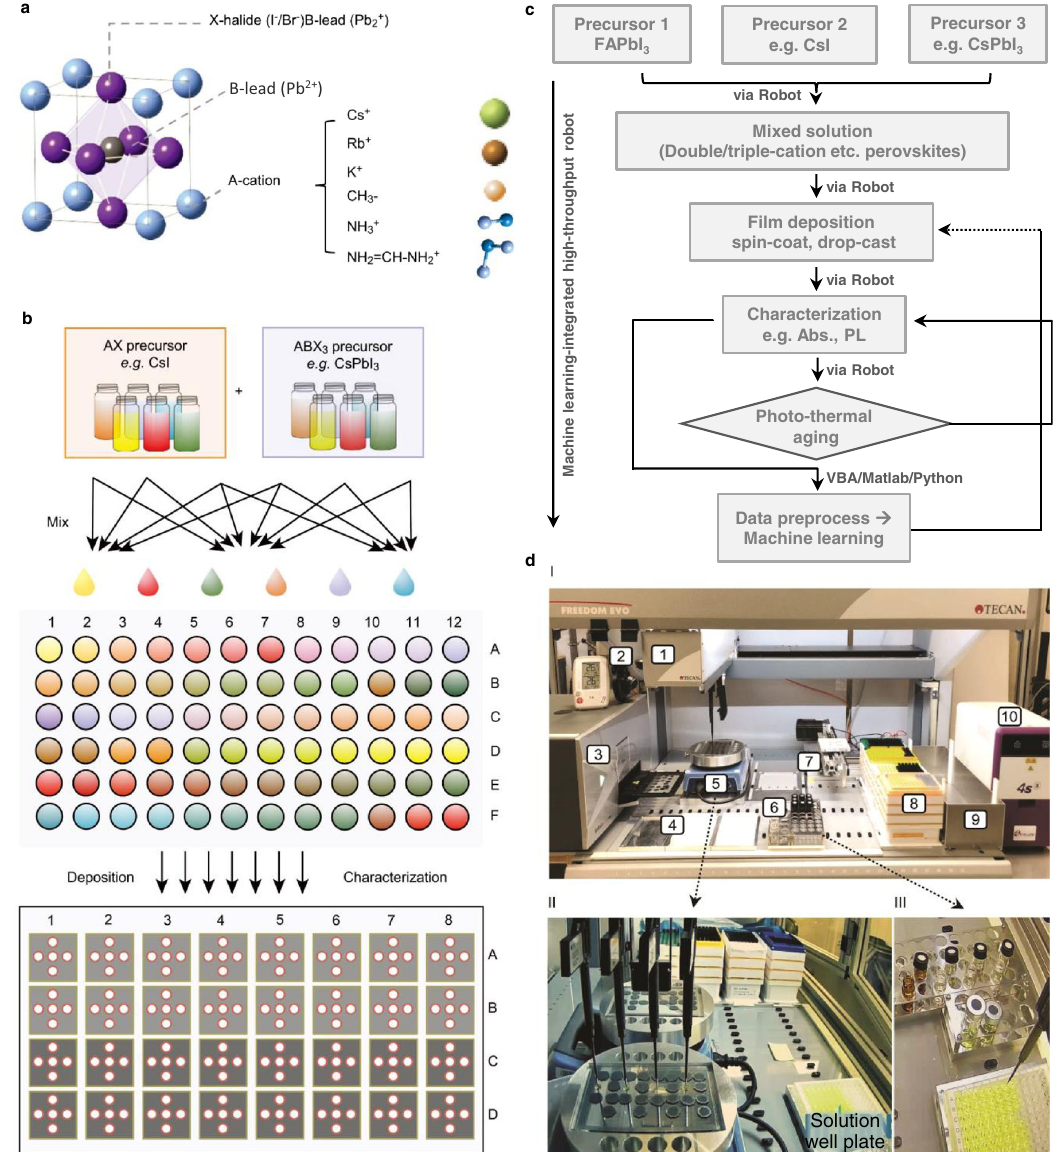
Fig. 1 Work fl ow of automatic stability study via high-throughput robot (HTRobot). a Crystal structure of perovskite with multiple cations, including potassium (K + ), rubidium (Rb + ), caesium (Cs + ), methylammonium (MA + ), and formamidinium (FA + ) . b Schematic of the work fl ow of HTRobot for automatic synthesis and characterization. The red circles in the bottom panel indicate the fi ve different positions tested on each sample. c Detailed work fl ow chart of the high-throughput operation to evaluate perovskite stability. d Photograph of the HTRobot system, including (1) robot arm with four pipettes; (2) camera and humidity meter; (3) spectrometer to record the absorbance and photoluminescence; (4) 96-well microplates to mix the precursors; (5) hotplate; (6) stock solution of PbI 2 , FAI, MAI, CsI, etc.; (7) sample stage; (8) pipette tips; (9) waste container; and (10) heat sealer to optionally fuse microplates with aluminum foil. I/II/III show panoramic views of the setup, top view of the fi lm fabrication and solution preparation,